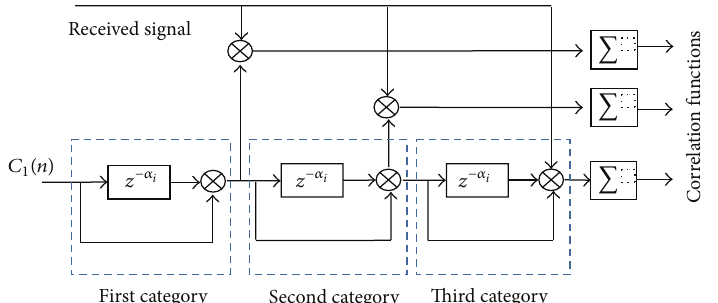
Figure 7: The proposed acquisition algorithm structure.